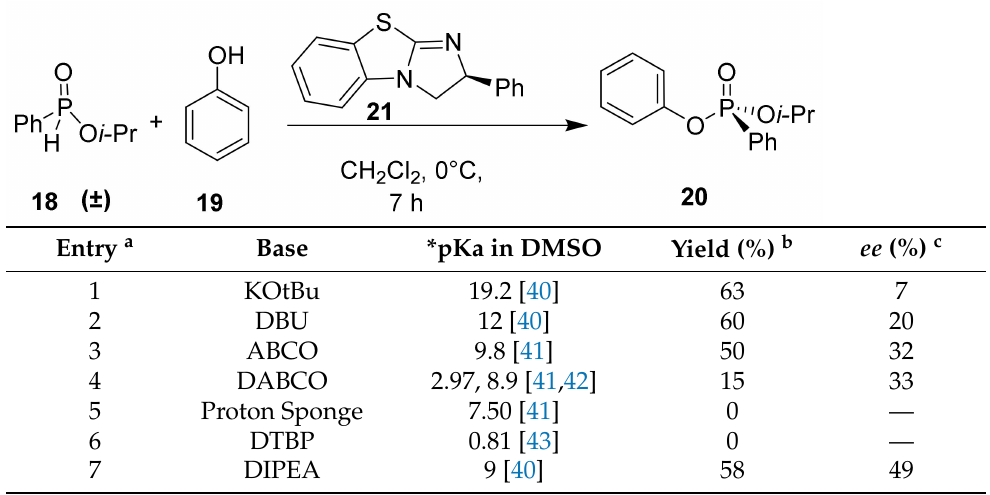
Table 1. Base effects on the reaction conditions.